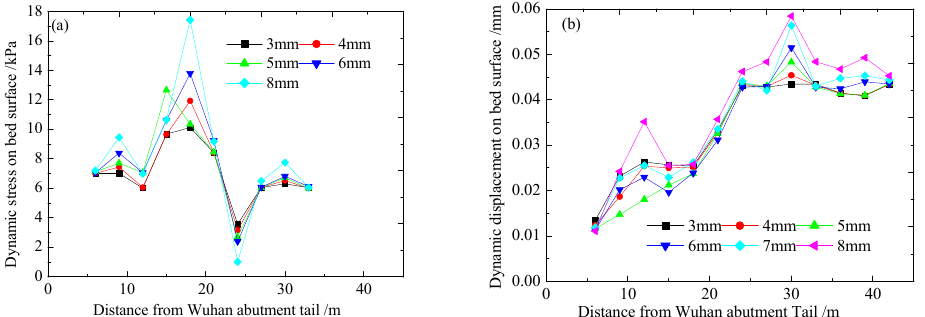
Figure 11. E ff ect of di ff erential settlement on the dynamic response of the subgrade surface layer: Figure 11. Effect of differential settlement on the dynamic response of the subgrade surface layer: ( a ) ( a ) dynamic stress; ( b ) dynamic dynamic stress; ( b ) dynamic displacement.